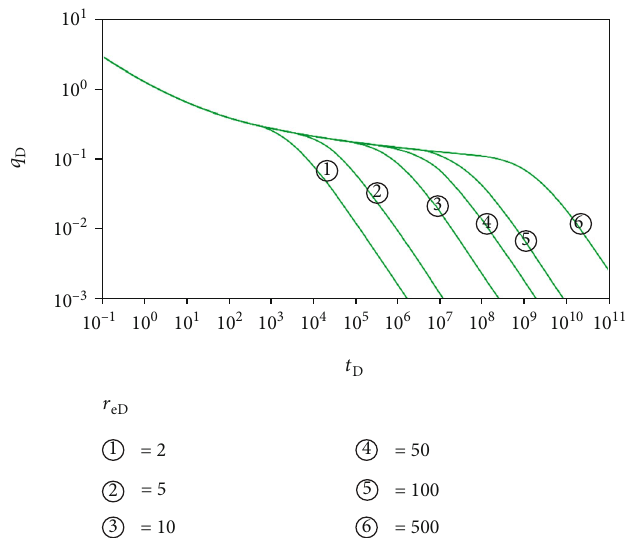
Figure 3: Type curves of a dimensionless production rate ( q